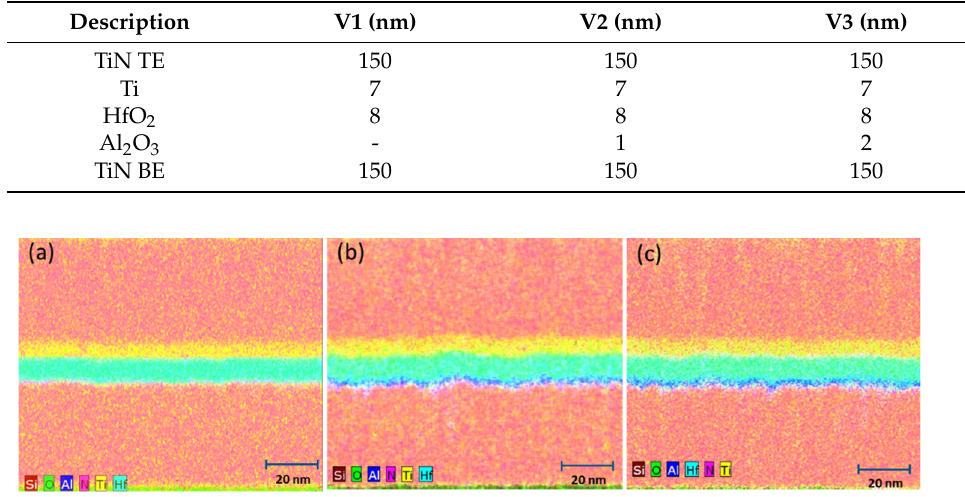
Table 1. Variants of memristive devices with respective layer thicknesses.